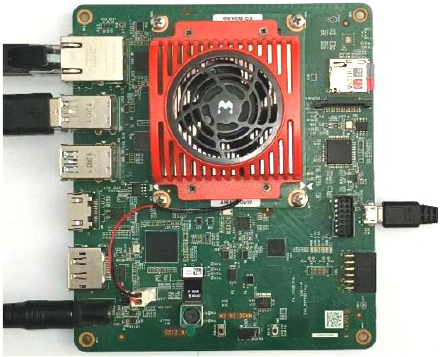
Figure 5. Xilinx KV260 FPGA hardware platform.